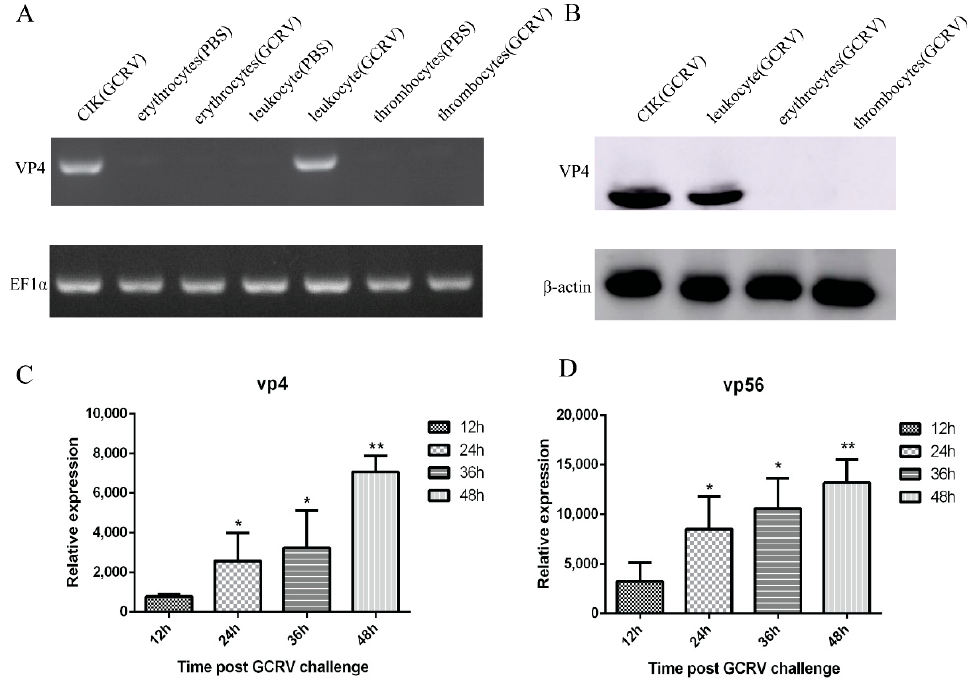
Figure 2. After grass carp reovirus II (GCRV-II) infection, leukocytes, thrombocytes, erythrocytes, and C. idella kidney (CIK) cells were detected. ( A ) PCR results showed that leukocytes and CIK cells detected GCRV-positive with VP4 primer and EF1 α as an internal reference, but erythrocytes and thrombocytes detected GCRV-negative. ( B ) Western blot results showed that with VP4 polyclonal antibody as primary antibody and β -actin as an internal reference, leukocytes and CIK cells detected GCRV-positive after infection, but erythrocytes and thrombocytes detected GCRV-negative. ( C , D ) Quantitative primers of VP4 and VP56 were used for qRT-PCR detection, respectively. The viral load of GCRV at 12 h, 24 h, 36 h, and 48 h after GCRV infection was detected, the control group was 0h after GCRV infection. Data of reporter assays and qPCR are shown as mean ± standard deviation (SD) of 6 wells of cell per group and are from one experiment representative of three independent experiments. Significance was calculated in relation to the control group. * p < 0.05, ** p < 0.01 (two tailed Student’s t -tests). The relative transcription levels were normalized to the transcription level of EF1 α gene and are represented as fold induction relative to the transcription level in control cells, which was set to 1.